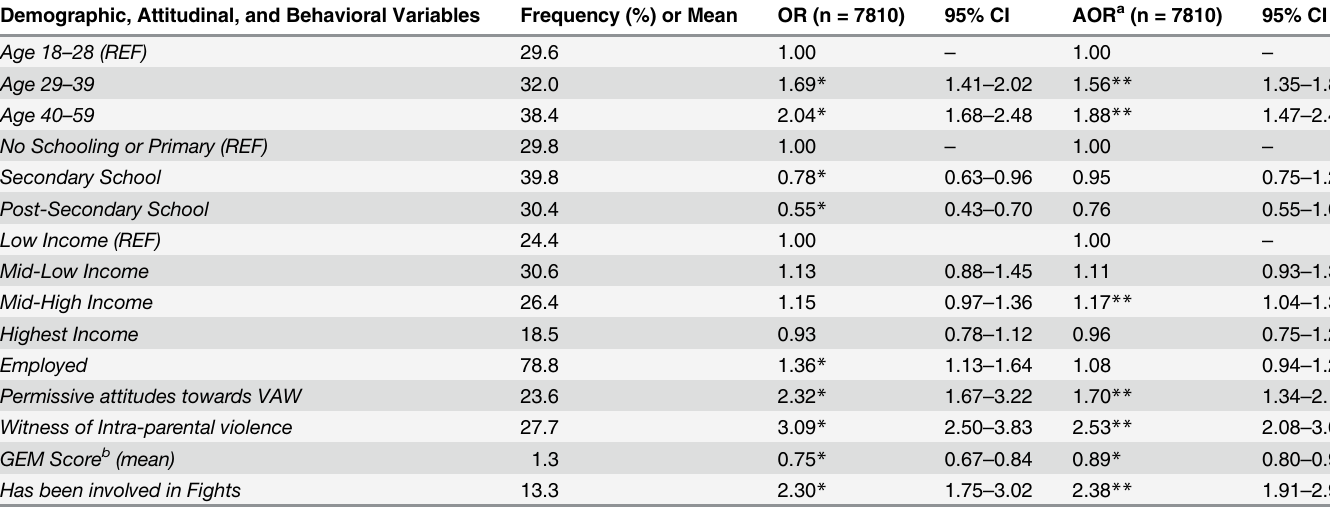
Table 3. Results from multivariate logistic regression, correlates of lifetime physical violence perpetration against a partner, presented as unadjusted and adjusted odds ratios a (all-country sample, n = 7806). Demographic, Attitudinal, and Behavioral